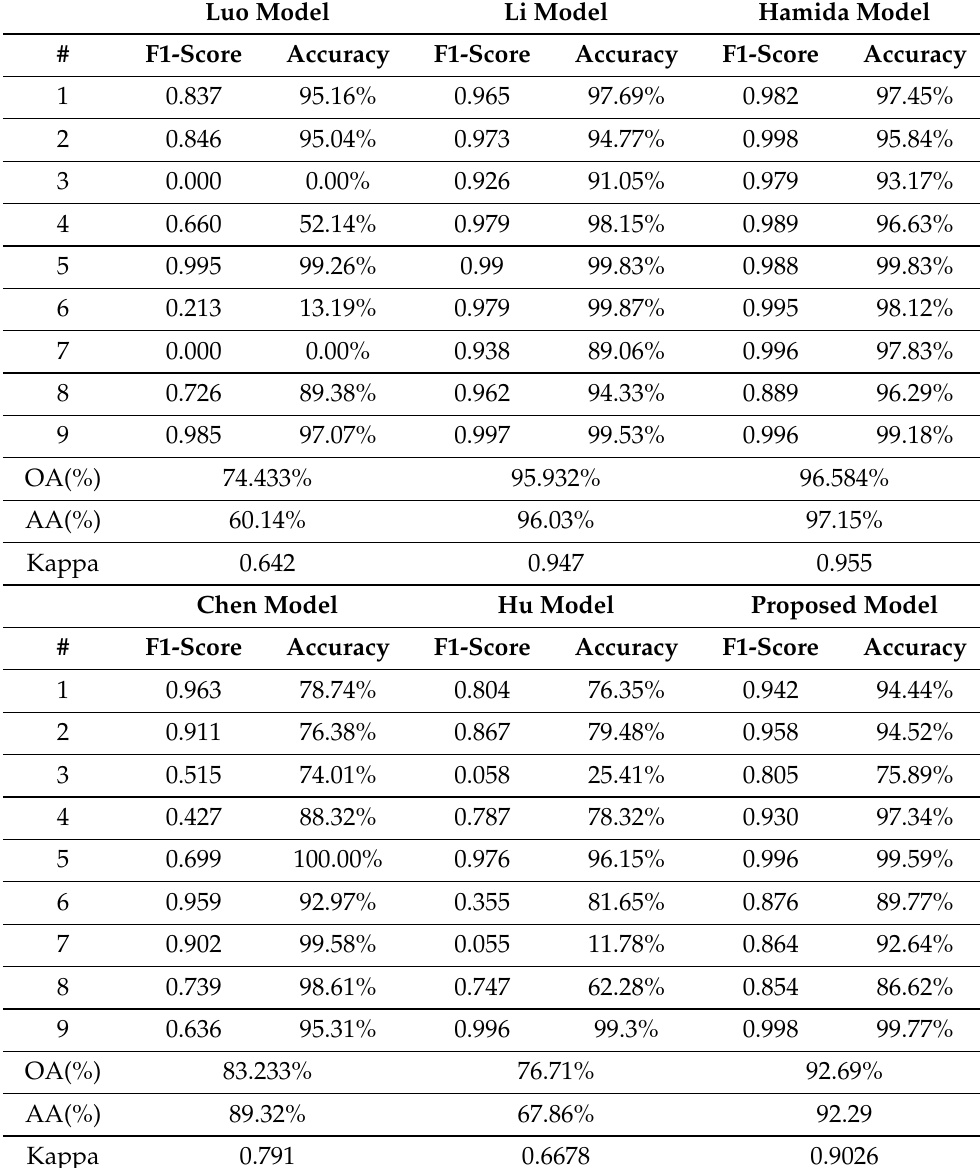
Table 8. Classification results of the Pavia University dataset to which random spatial information is not